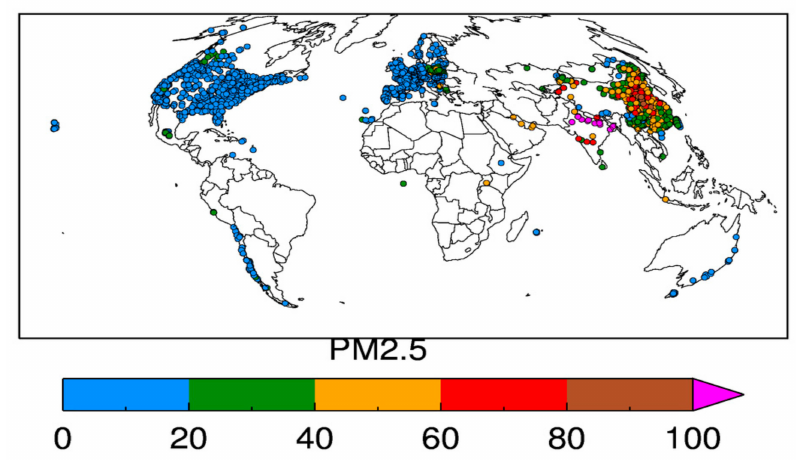
Figure A1. Global distribution of annual mean PM 2.5 concentrations in µ gm − 3 from ground monitors for 2018. Note that there is reasonable coverage in North America, Europe, and parts of China; much of the world has no monitors to assess PM 2.5